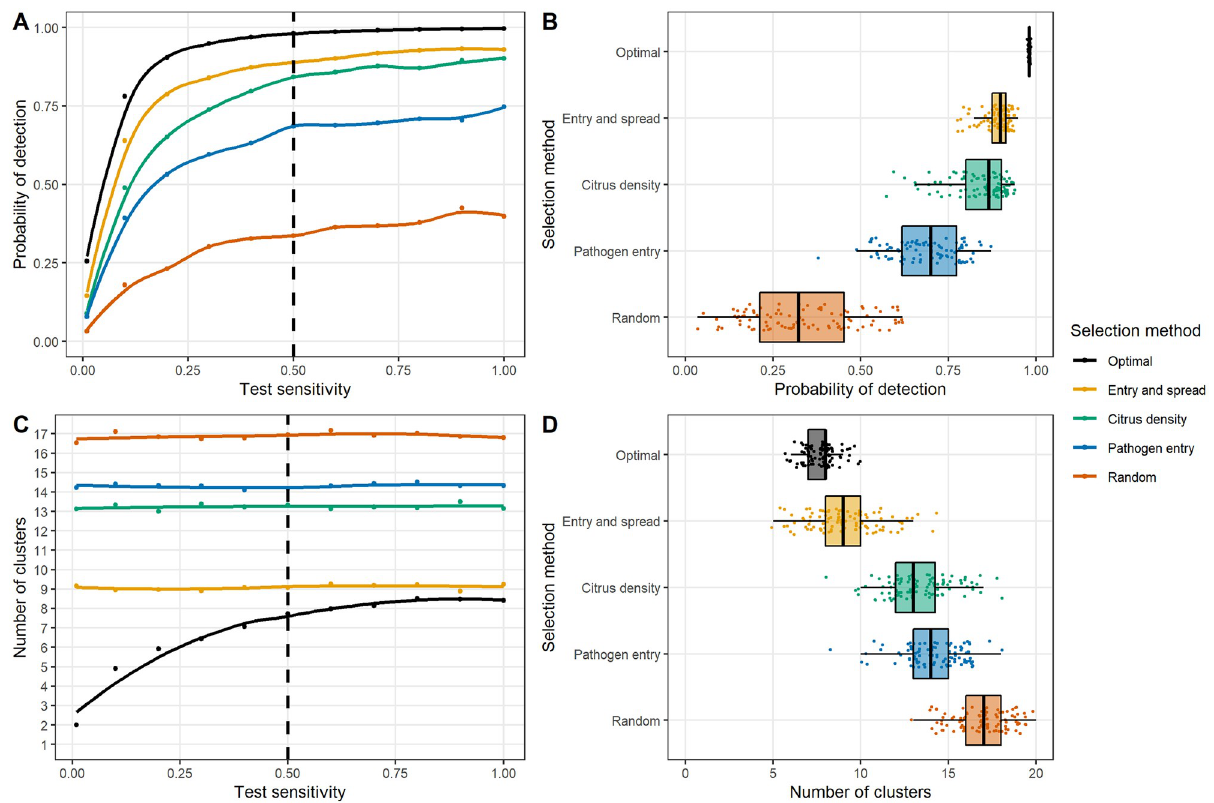
Fig 4. Impact of varying test sensitivity on detection probability and sampling site clustering. These plots show the effect of different site-selection strategies on the detection probability or number of clusters. We consider 5 selection strategies: an optimised arrangement and weighted sampling according to 4 different ‘risk metrics’—the product of travel census probabilities and citrus density (‘Entry and spread’), citrus density, probability of entry according to the travel census model (‘Pathogen entry’), and random (that is, unweighted) selection. All selection strategies were repeated 100 times. Plots A and B show the detection probability for these different selection strategies, and plots C and D show the number of clusters (with a cluster being all points within 20 km of each other), all with fitted locally weighted regression curves. Plots A and C show the mean probability of detection or number of clusters, with the vertical dashed line representing the ‘baseline’ scenario of a diagnostic sensitivity of 0.5. Plots B and D show the variation in individual-level selection runs under this baseline scenario. The data used to create these plots can be found at